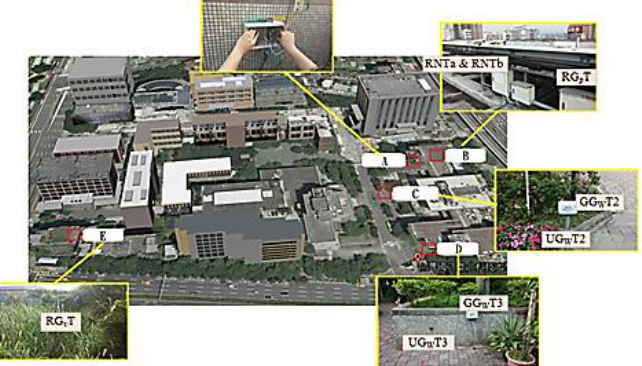
Figure 3. Sensor distribution (modified from Google Maps). The explanation for (A) – (E) is in Table